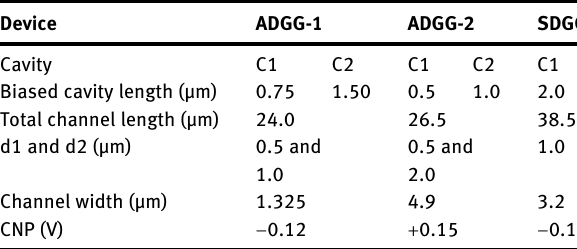
ampli fi cation of stimulated emission to the incident THz waves. We fi rst modeled such a GDPP active metasurfaces and numerically calculate the temporal evolution of the in- plane electric fi eld component after turning on the dc-current fl owusingself-consistentsimulationbasedonquasi-classical Boltzmann and Poisson equations. The simulation results demonstrated the development of THz self-oscillation at the plasmon mode frequencies depending on the plasmon cavity dimensions and the carrier densities [70]. The THz time-domain spectroscopy (THz-TDS) was employed to measure the changes in the THz pulses transmitted through the graphene plasmonic cavities of type C1 (C2) when sweeping V ( V ) and keeping the g1 g2